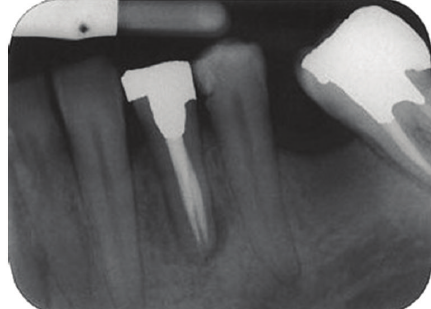
Figure 4: A 3-month recall shows dramatic healing.